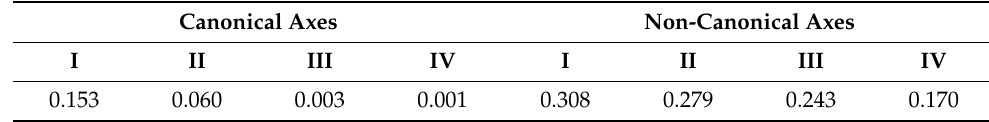
Table 5. Redundancy analysis evaluating the relationships between PF re Ts and PF ef